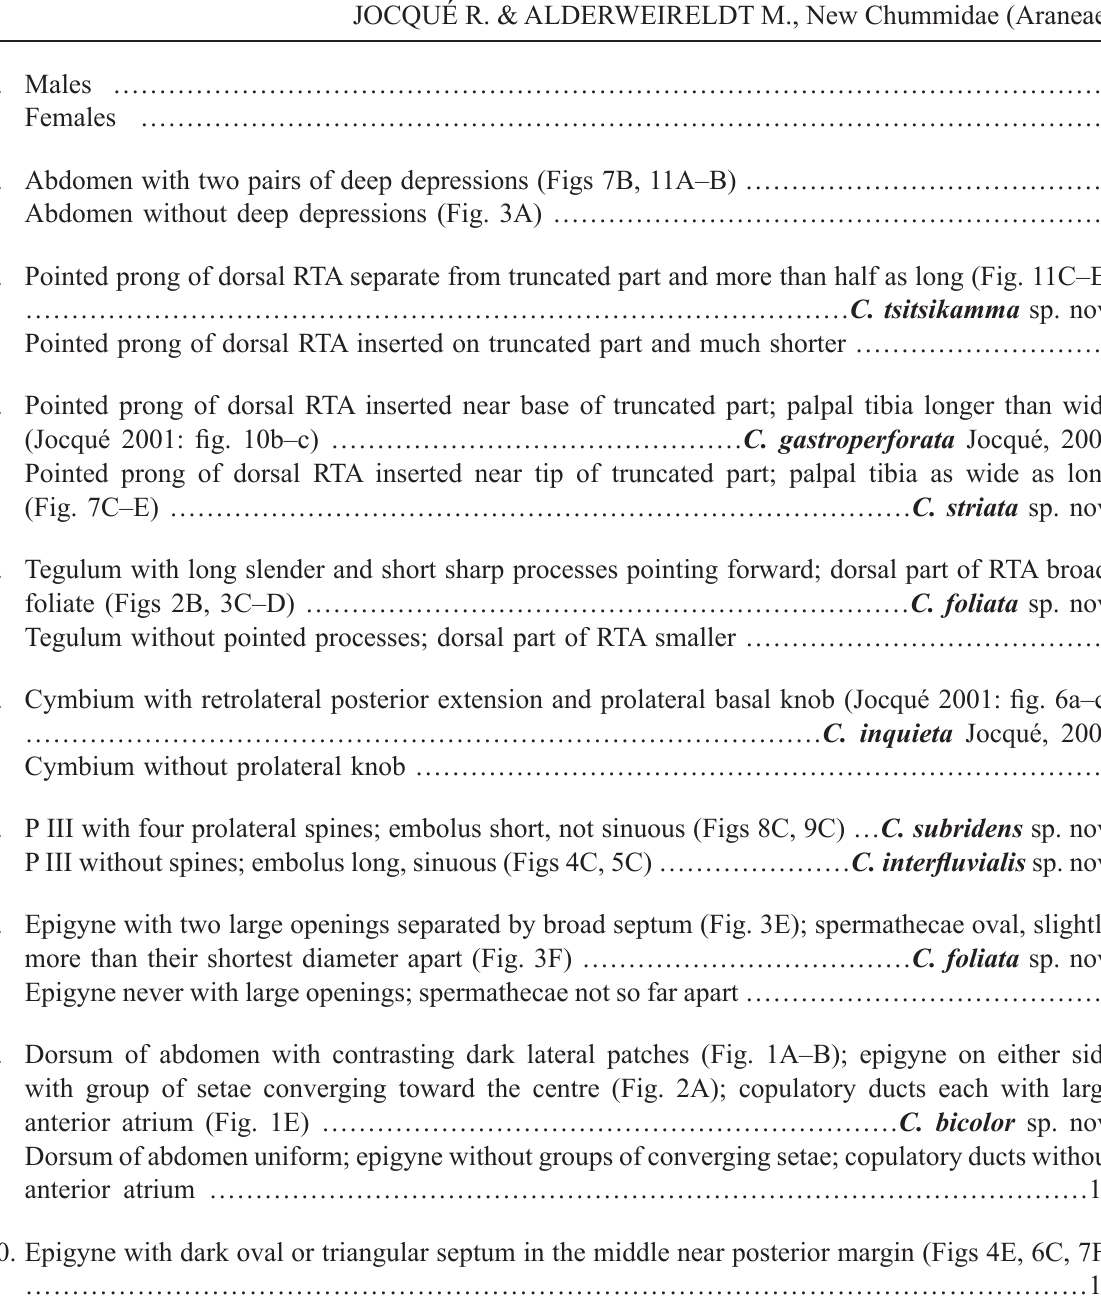
Posterior rim of epigyne not deeply